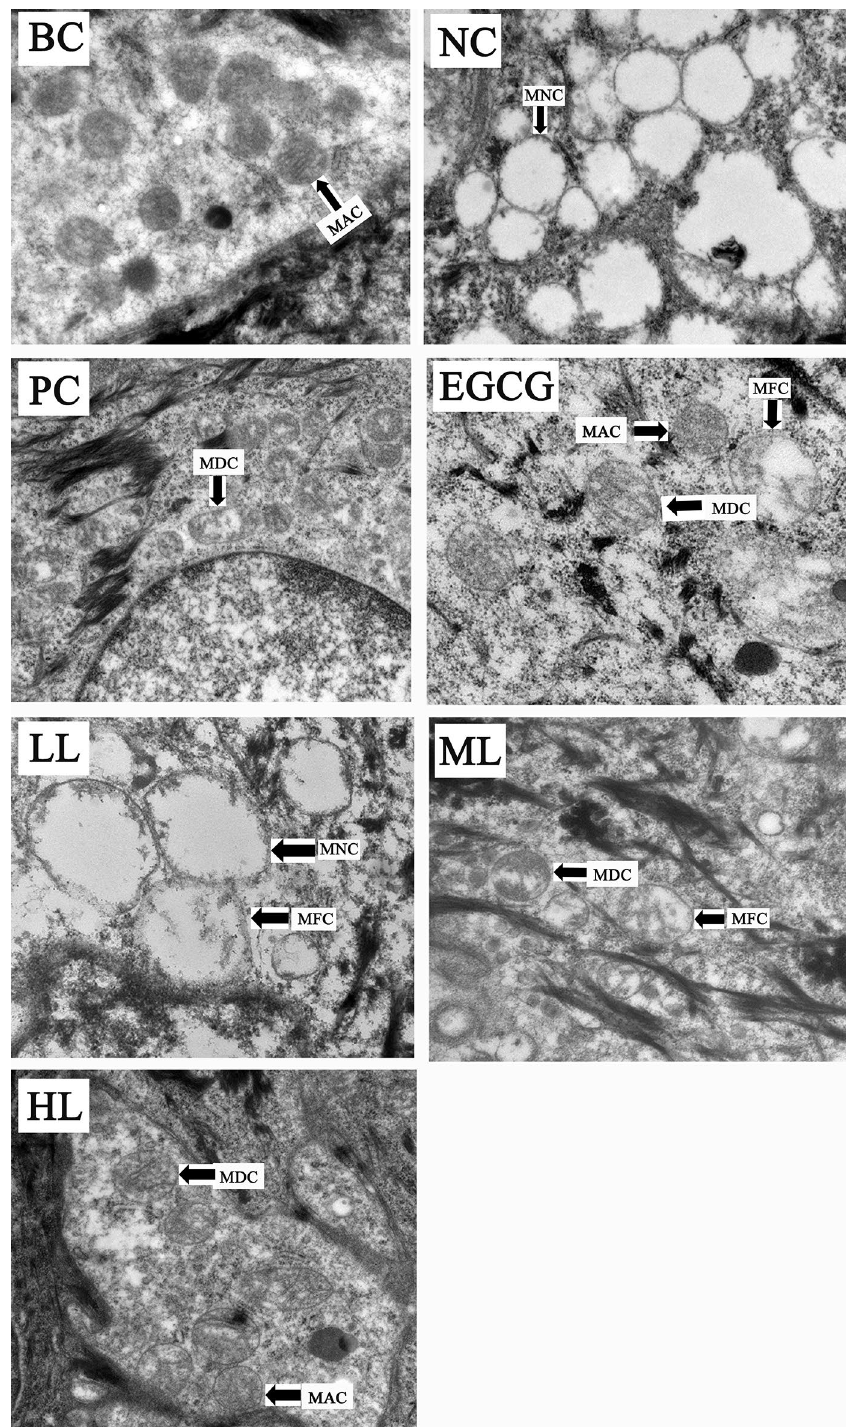
Figure 4. Effect of GCG on UVB-induced damage of mitochondria in skin of female hairless mice. BC blank control, NC negative control, PC positive control, EGCG EGCG treatment, LL low level GCG, ML medium level GCG, HL high level GCG, MAC mitochondrion with abundant cristae, MDC mitochondrion with decreased cristae, MFC mitochondrion with few cristae, MNC mitochondrion without